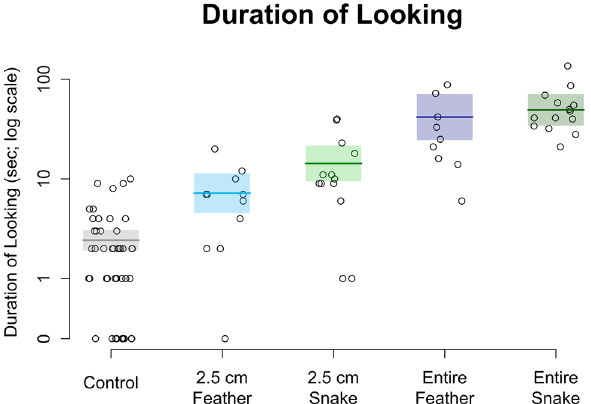
Figure 4. Observed durations of looking (s) in response to five stimulus types and model predictions. Predicted durations are from a negative binomial mixed model. Center lines give the predicted means and shaded boxes show one standard error intervals. The vertical axis is on the natural-log scale, though the axis tick marks are labeled according to the original scale of time in seconds. Observations with a duration of zero seconds have been superimposed at the bottom of the vertical axis for